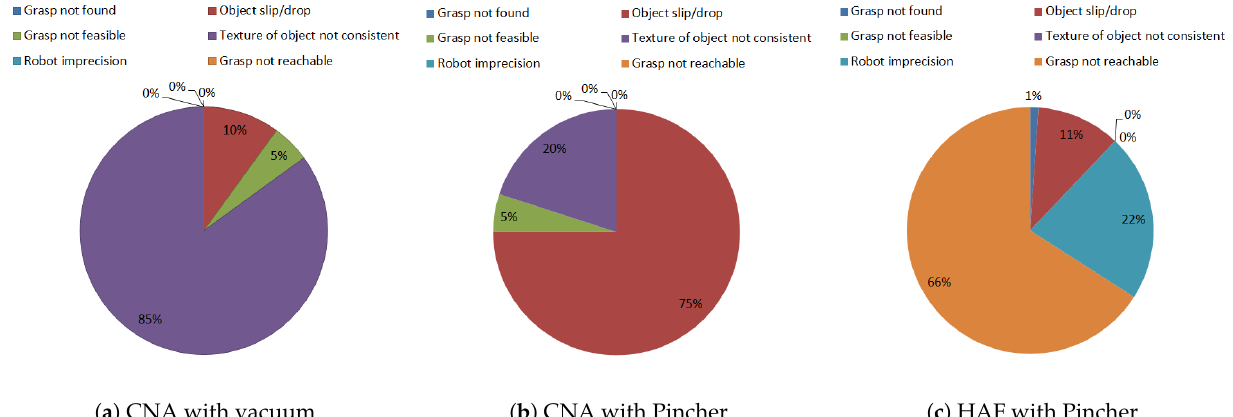
Figure 15. Reasons of failure for the different